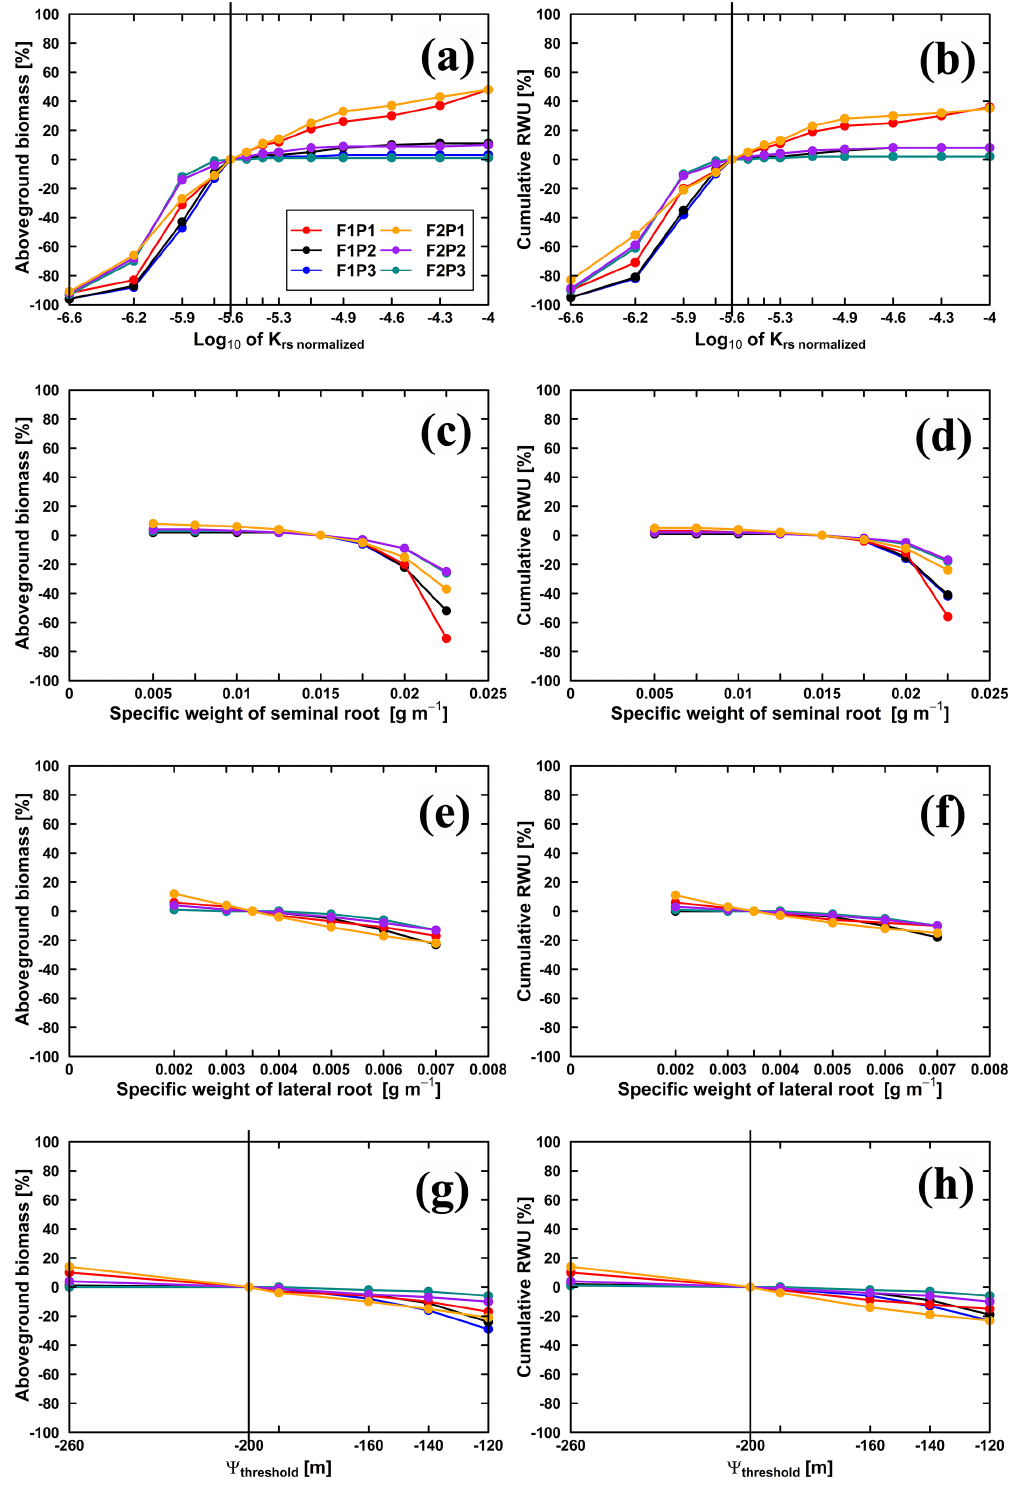
Figure 11. Relative changes of simulated (Co model) aboveground biomass at harvest (a, c, e, g) and cumulative RWU (b, d, f, h) (from 15 March to harvest on 23 July 2016) with the changing K r , specific weights of seminal and lateral roots and leaf pressure head s , normalized threshold ( (cid:57) threshold ) in the sheltered (P1), rainfed (P2), and irrigated (P3) plots of the stony soil (F1) and the silty soil (F2). Vertical lines = 0 . 2554 × 10 − 5 (cmd − 1 ), while in (g, h) the vertical lines indicate the (cid:57) in (a, b) indicate the original value K r s , normalized −